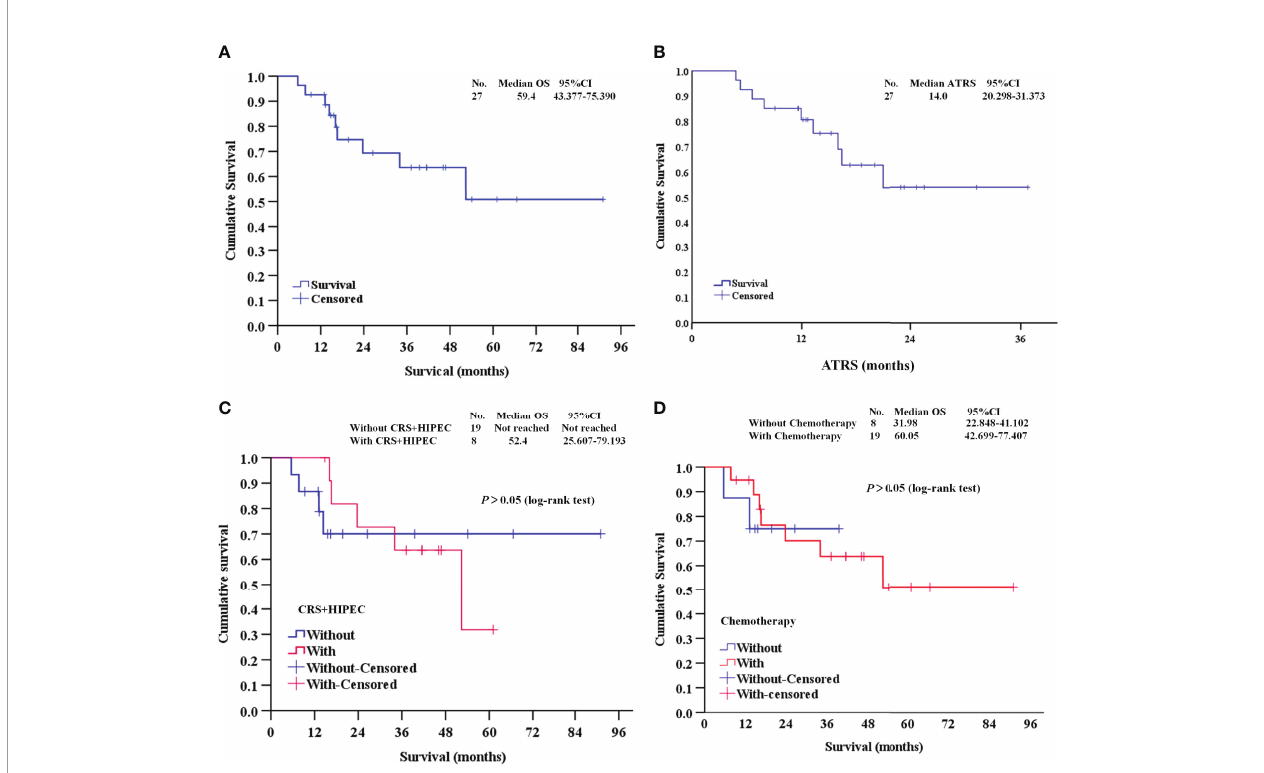
FIGURE 3 | Survival analysis of this study. (A, B) The OS and ATRS of the 27 DMPM patients; (C) Survival analysis between patients treated with vs. without CRS+HIPEC; (D) Survival analysis between patients treated with vs. without previous chemotherapy. OS, overall survival; ATRS, apatinib-treatment-related survival; CRS+HIPEC, cytoreductive surgery + hyperthermic intraperitoneal chemotherapy.